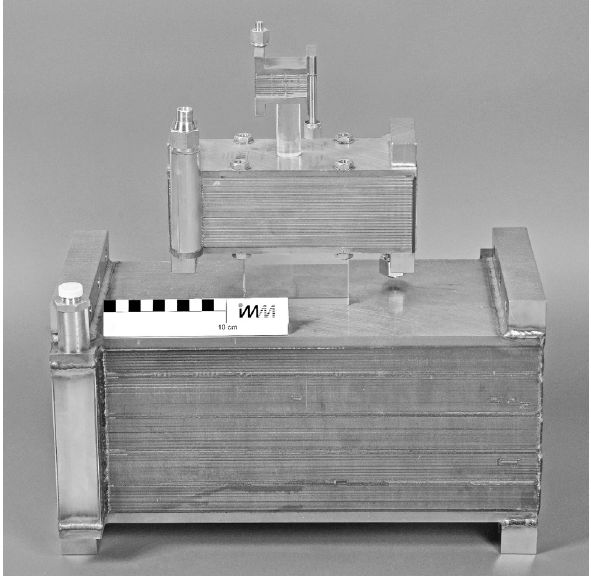
Figure 16 Comparison of the dimensions of laser welded stacked reactor: top – plates 17 × 50 mm, mid – plates 60 × 200 mm, below – first prototype with plates 150 × 400